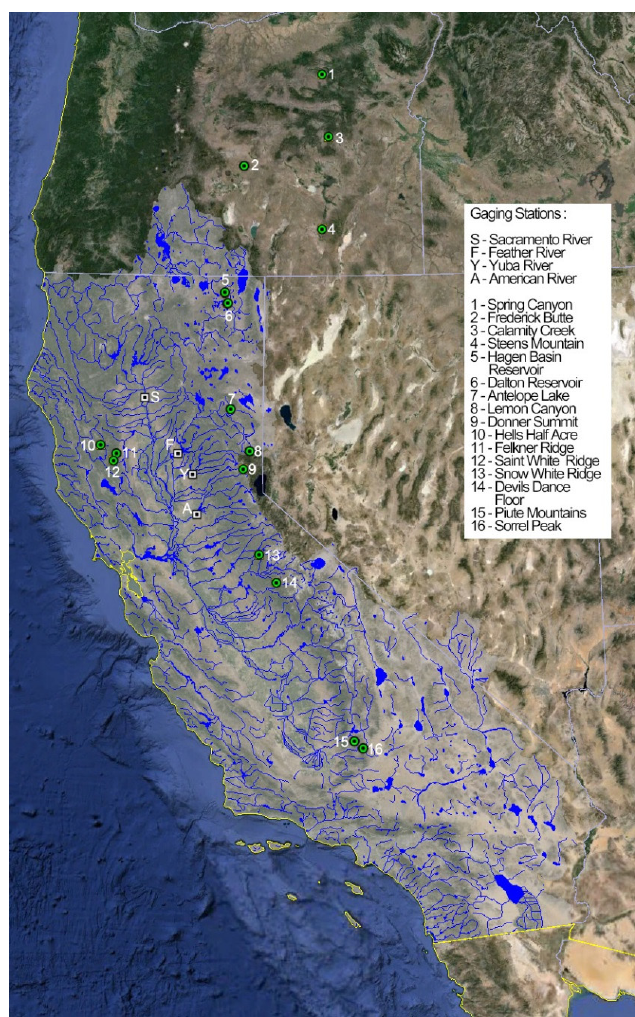
Figure 1. Study area, tree ring sites, and streamflow sites. Table 1. Tree ring sites and streamflow observatory specification [58].